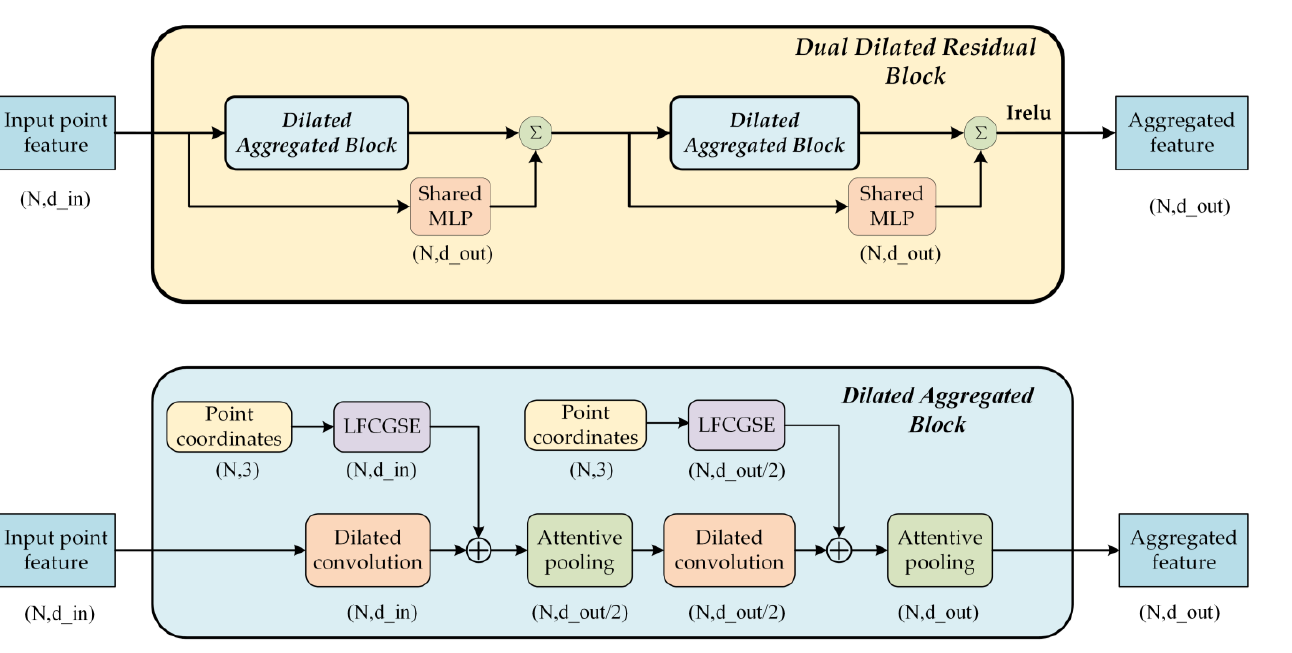
Figure 4. Dual dilated residual block.